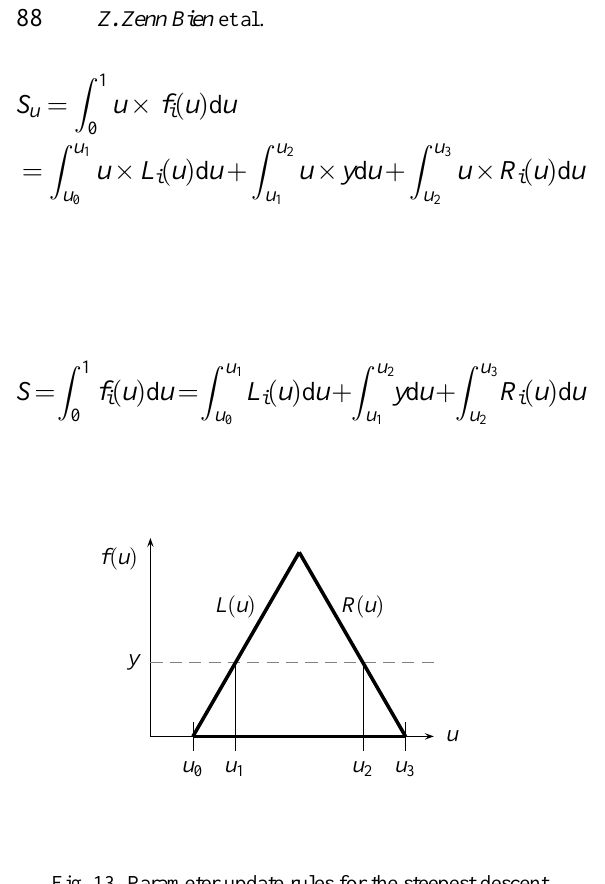
Fig. 13. Parameter update rules for the steepest descent method